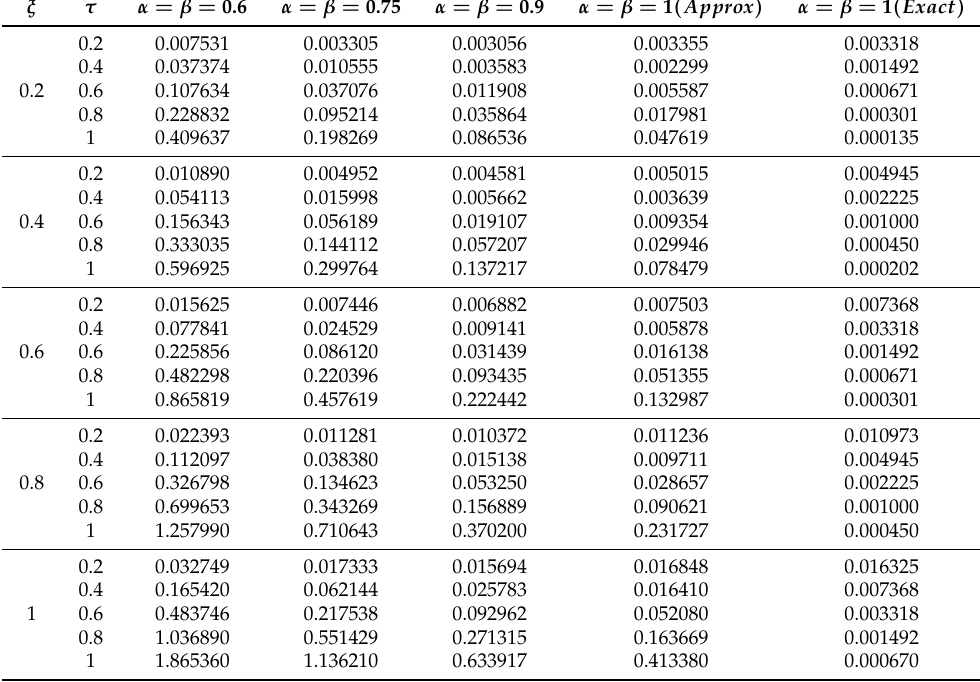
Table 4. The exact, NTDM CF and NTDM ABC solutions of u ( ξ , ζ , τ ) for Example 2 at different fractional-order of α and β with l = 4 for different ξ and τ when ζ =